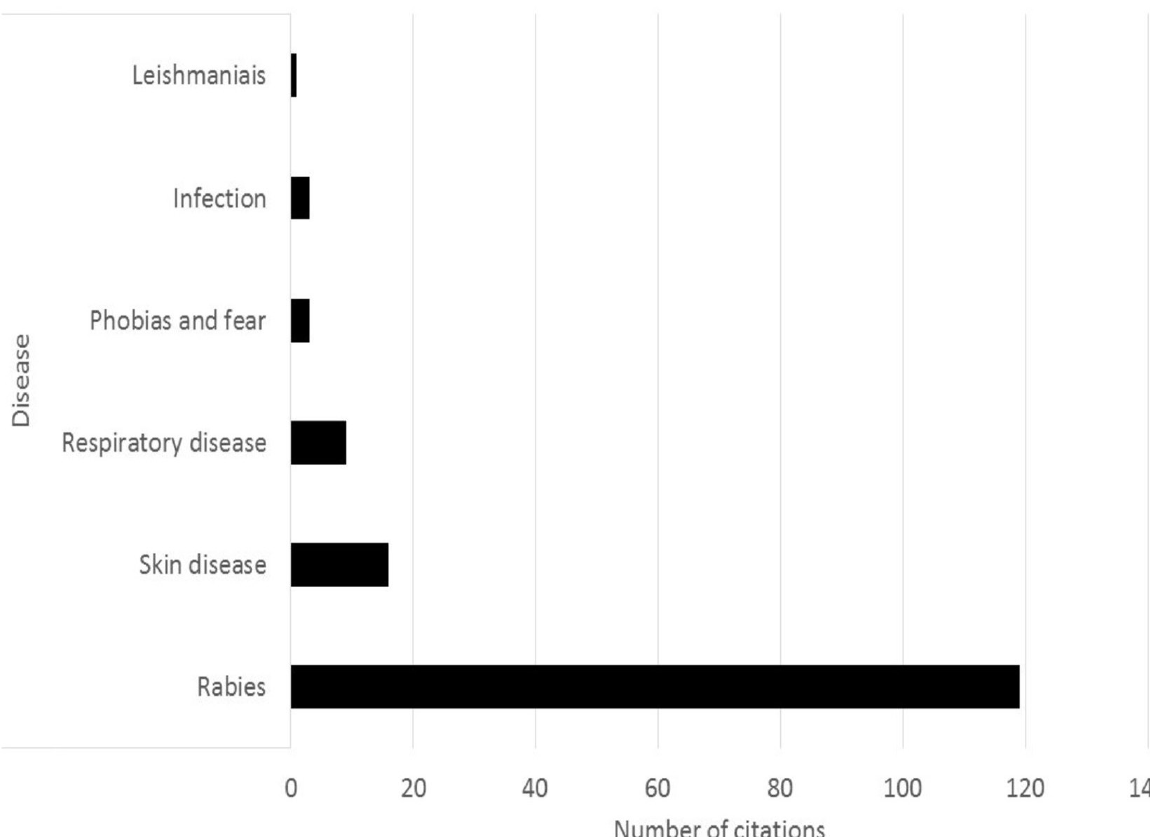
Figure 3. Diseases cited by interviewees related to crab-eating